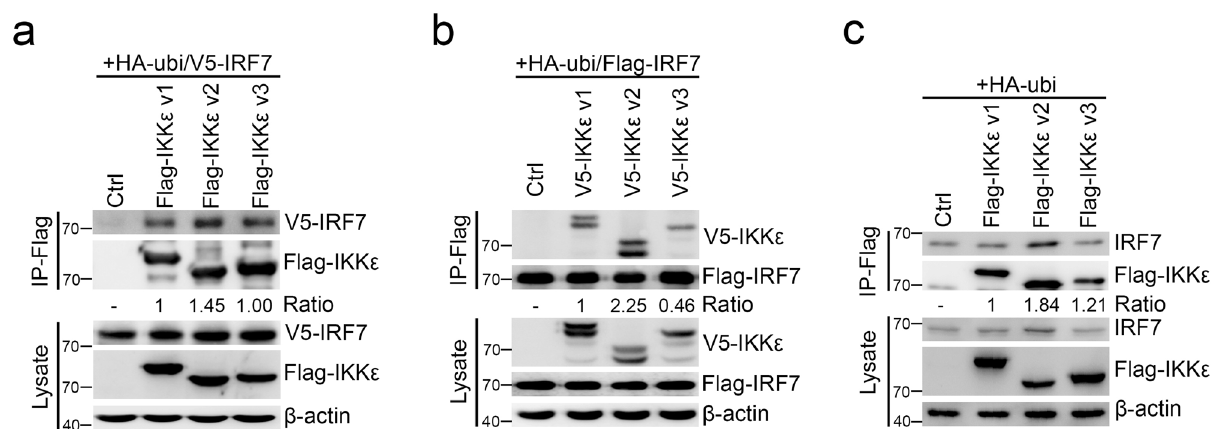
Fig. 4 IRF7 preferentially interacts with IKK ε v2. a , b IRF7 preferentially interacts with IKK ε v2 in the presence of ubiquitin. IRF7 and each IKK ε isoform were ectopically expressed in HEK293 cells in the presence of ubiquitin. The lysates were subjected to immunoprecipitation to precipitate Flag-IKK ε ( a ) or Flag-IRF7 (b) with anti-Flag beads, respectively. V5-IRF7 ( a ) and V5-IKK ε isoforms ( b ) were detected by anti-V5 antibody. c IKK ε v2 strongly interacts with endogenous IRF7 in presence of ubiquitin. RD cells were cotransfected with each Flag-IKK ε isoform and HA-ubi. Total lysates were adapted to immunoprecipitation using anti-Flag beads and endogenous IRF7 was detected by anti-IRF7 antibody. β -actin was served as an internal